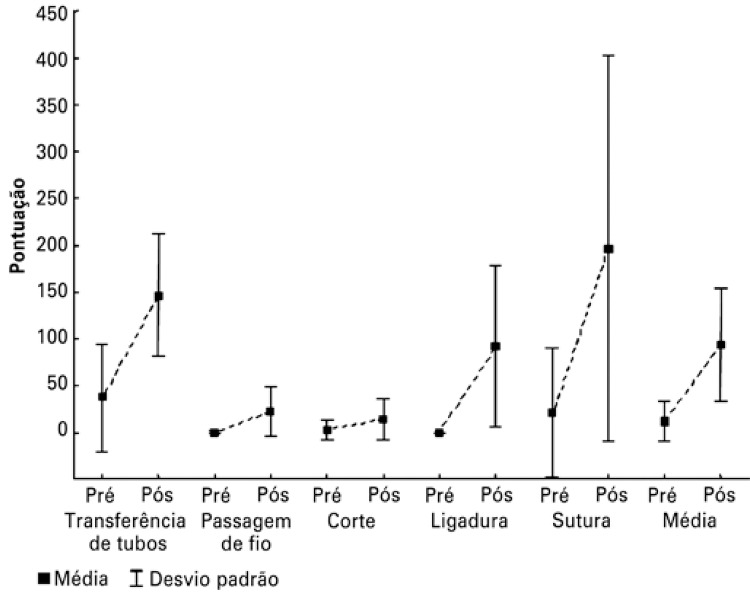
Desempenho antes e depois do treinamento, para diferentes exercícios laparoscópicos, em estudantes de Medicina